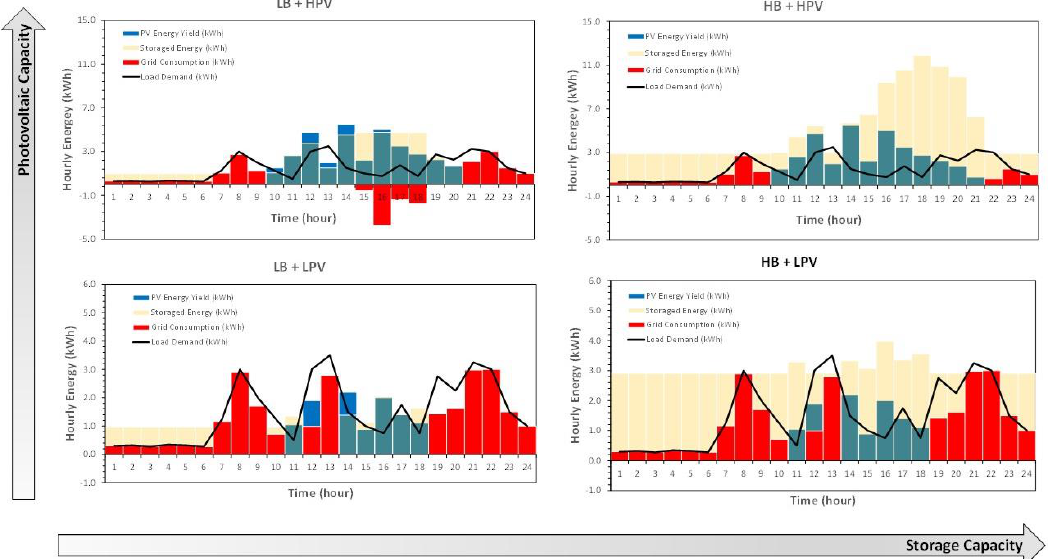
Figure 7. Daily energy balances according to the battery and PV system sizes for Case 3. When the stored energy is lower than the PV energy yield in an hour, the bar shows in a dark blue colour the PV energy yield and in a greenish-blue colour the stored energy. Otherwise, the PV energy yield is shown in a greenish-blue colour.